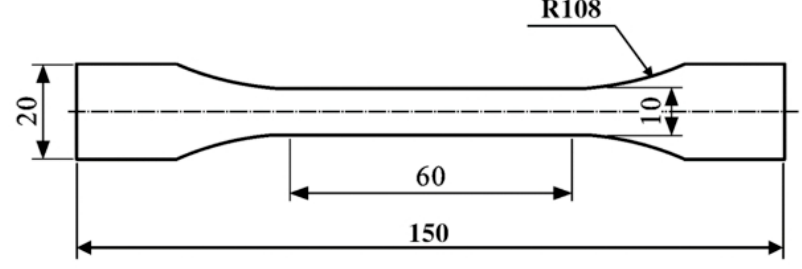
Figure 4. Geometric shape of dumbbell shaped specimen.